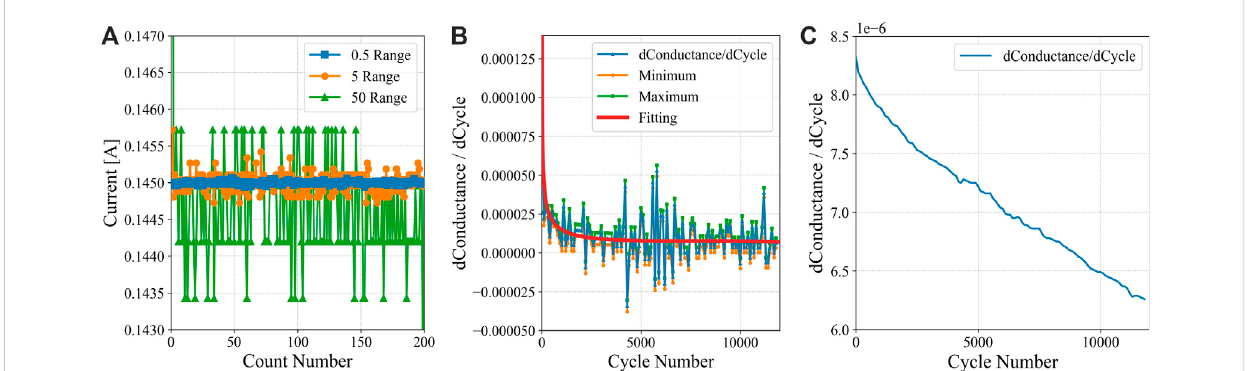
FIGURE 13 Analyses of an LMO/LTO cell at a C/20 rate, showing (A) variance of current measured by a Maccor test channel at 0.5, 5 and 50 A ranges. Panel (B) shows the differential conductance pro fi les (dK/dn) for cell D-58, showing the original pro fi le and pro fi les adjusted for the maximum (green) and minimum(orange)errors(perEqs.2and3).TheSREdifferentialoutcomeisincludedin (B) .Panel (C) shows thedifferencesbetween thesemaximumand minimum error outcomes over cycle